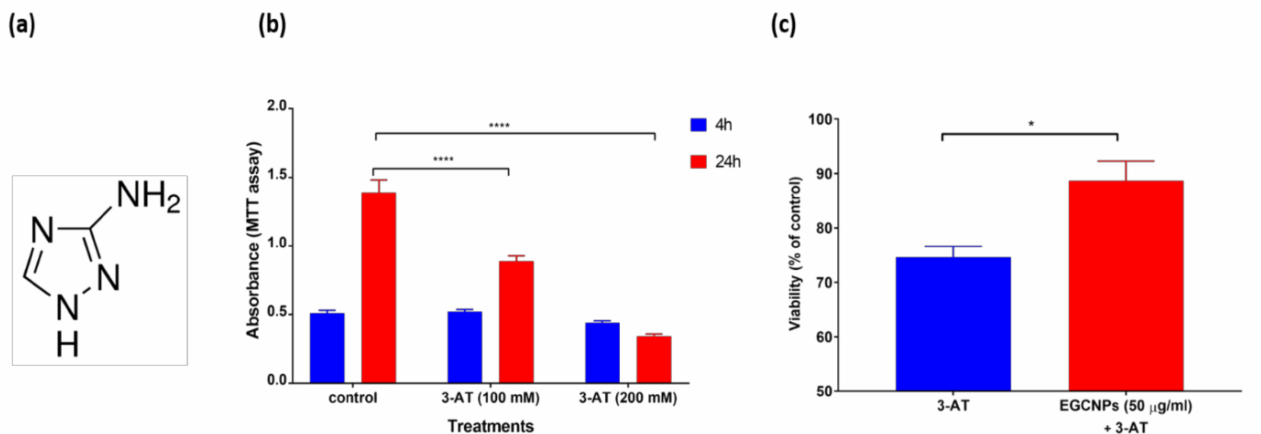
Figure 3. ( a ) Chemical structure of 3-amino-1,2,4-triazole (3-AT), a catalase inhibitor, and ( b ) dose- and time-dependent effect of the catalase inhibitor 3-AT on HLECs viability measured by the MTT assay. Asterisks denote statistical significance from the negative control (two-way ANOVA followed by Tukey’s multiple comparisons test, n = 3, **** p ≤ 0.0001). ( c ) Catalase-mimetic activity of EGCNPs in HLECs; cells were exposed to 3-AT for 24 h. EGCNPs protect against damage induced by the catalase inhibitor 3-AT (100 mM). The asterisk denotes statistical significance ( n = 3, p < 0.05, Student’s t -test). Error bars are presented as means ±